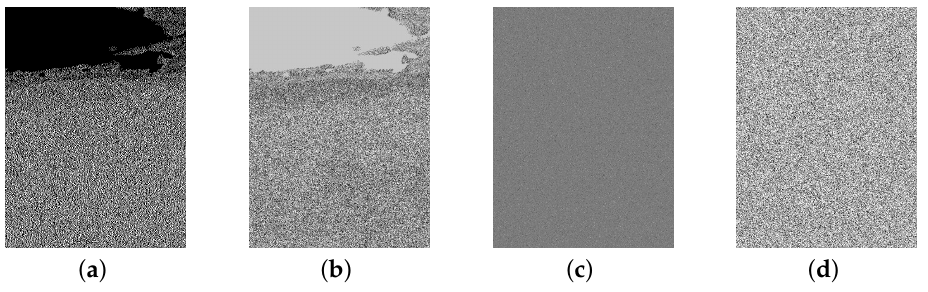
Figure 7. The procedure of order differential encryption. ( a ) Order difference of R; ( b ) Value replacement; ( c ) Position permutation; ( d ) Encrypted R.